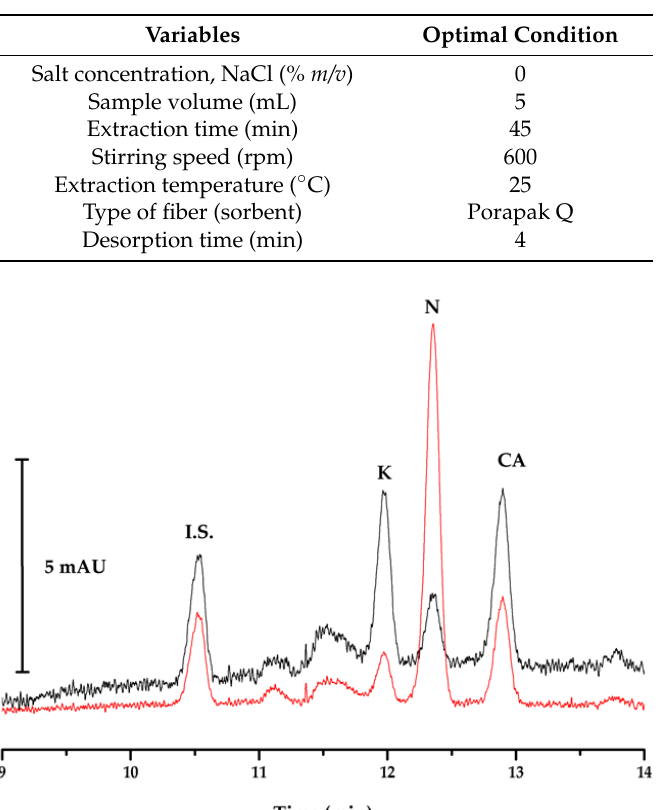
Table 4. Optimized variables of solid-phase microextraction.